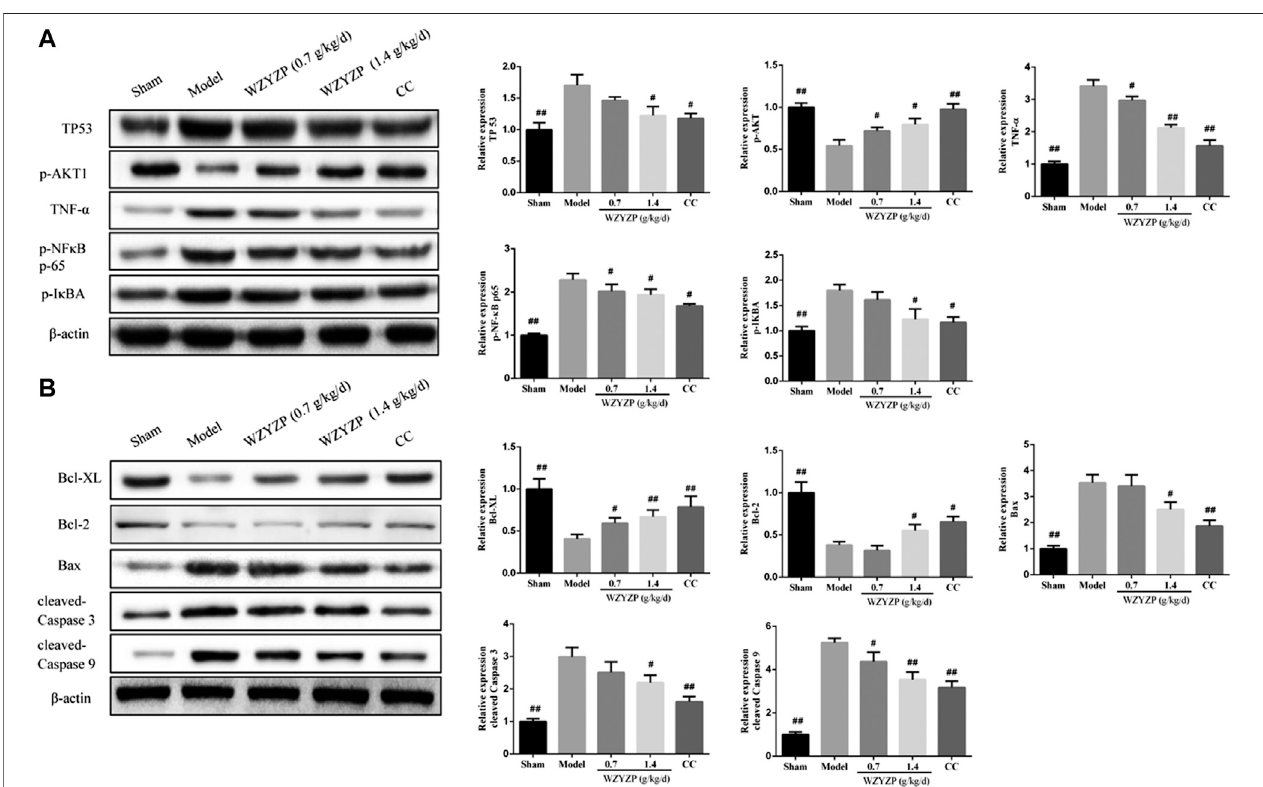
FIGURE 5 | Effect of the WZYZP on the hub targets and apoptosis pathway. (A) Protein expression of TP53, p-AKT1, TNF- α , p-NF- κ B p65, and p-I κ BA in rat testes. (B) ProteinexpressionofBcl-XL,Bcl-2,Bax,cleaved-Caspase3,and cleaved-Caspase9inrattestes.Theproteinexpression wasdetectedwithawestern blot assay. β -actin was used as control. # p < 0.05 vs Model group, ## p < 0.01 vs Model group.